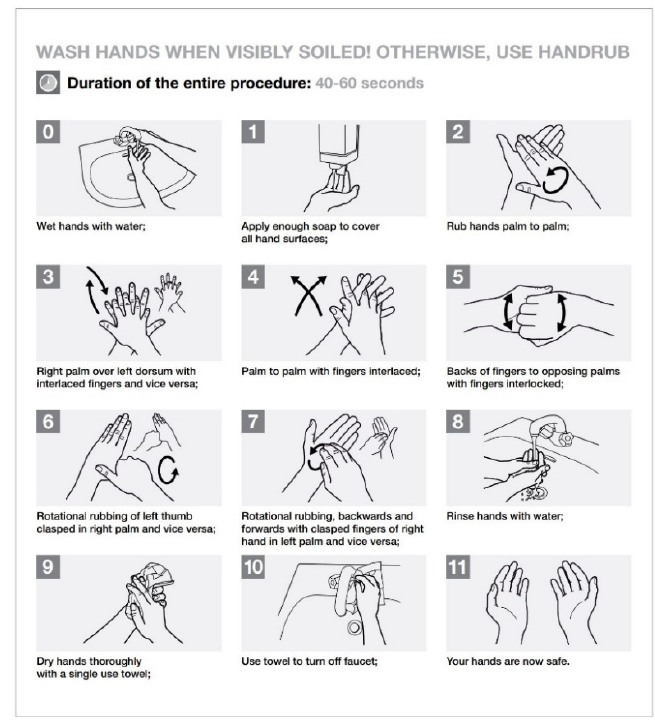
Figure 4. How to Hand Wash? [From: WHO Patient safety. Hand Hygiene: Why, How & When? Revised August 2009 https://www.who.int/gpsc/5may/tools/workplace_reminders/en/ (Accessed on 24 March 24, 2020)].